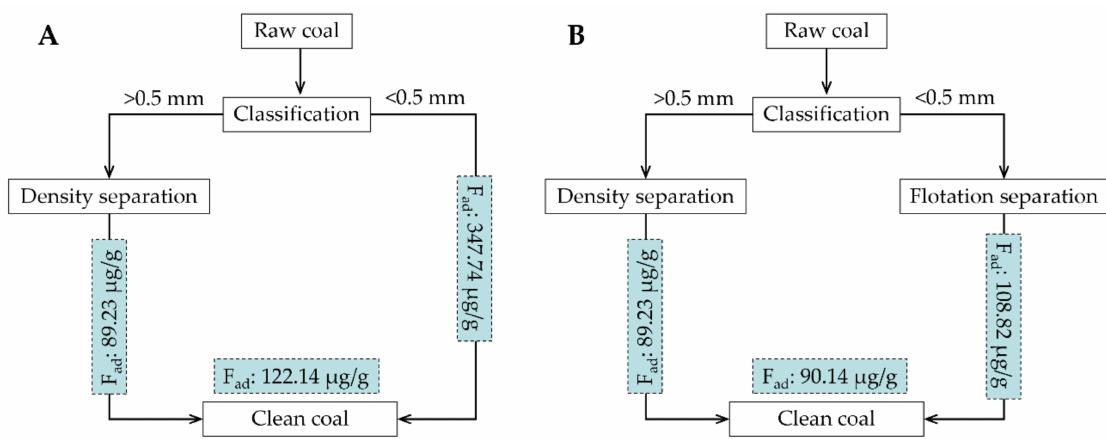
Figure 9. The proposed beneficiation circuits for <50 mm coal. ( A ) No treatment of <0.5 mm coal; ( B ) <0.5 mm coal treated by flotation